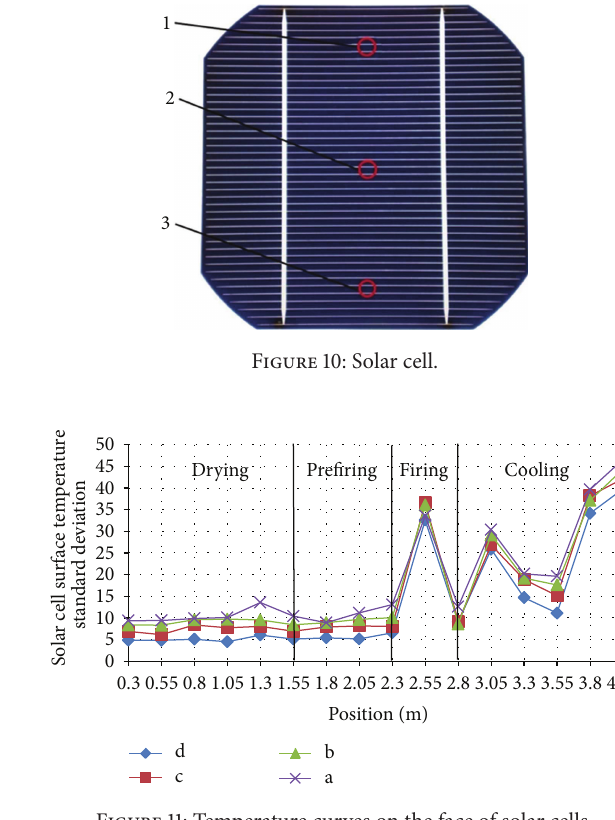
Figure 11: Temperature curves on the face of solar